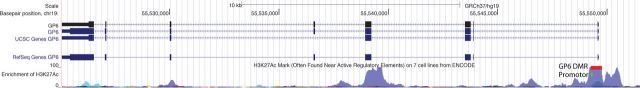
the GP6 gene (derived from the UCSC genome browser) with
illustrations of the promoter [19] (in
green) and the DMR (in red) in relation to prenatal exposure to lead. The gene is
transcribed in 3′–5′ direction (from the right to the left)